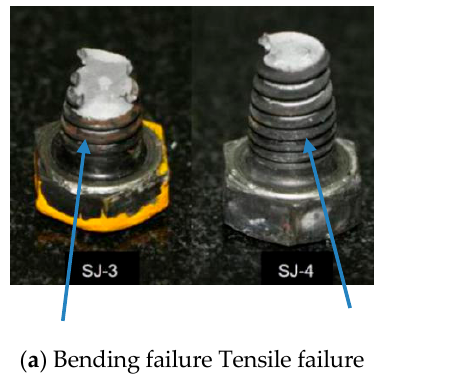
Figure 10. Internal damage of failure mode II. ( a ) Bolt fracture; ( b ) Core concrete.